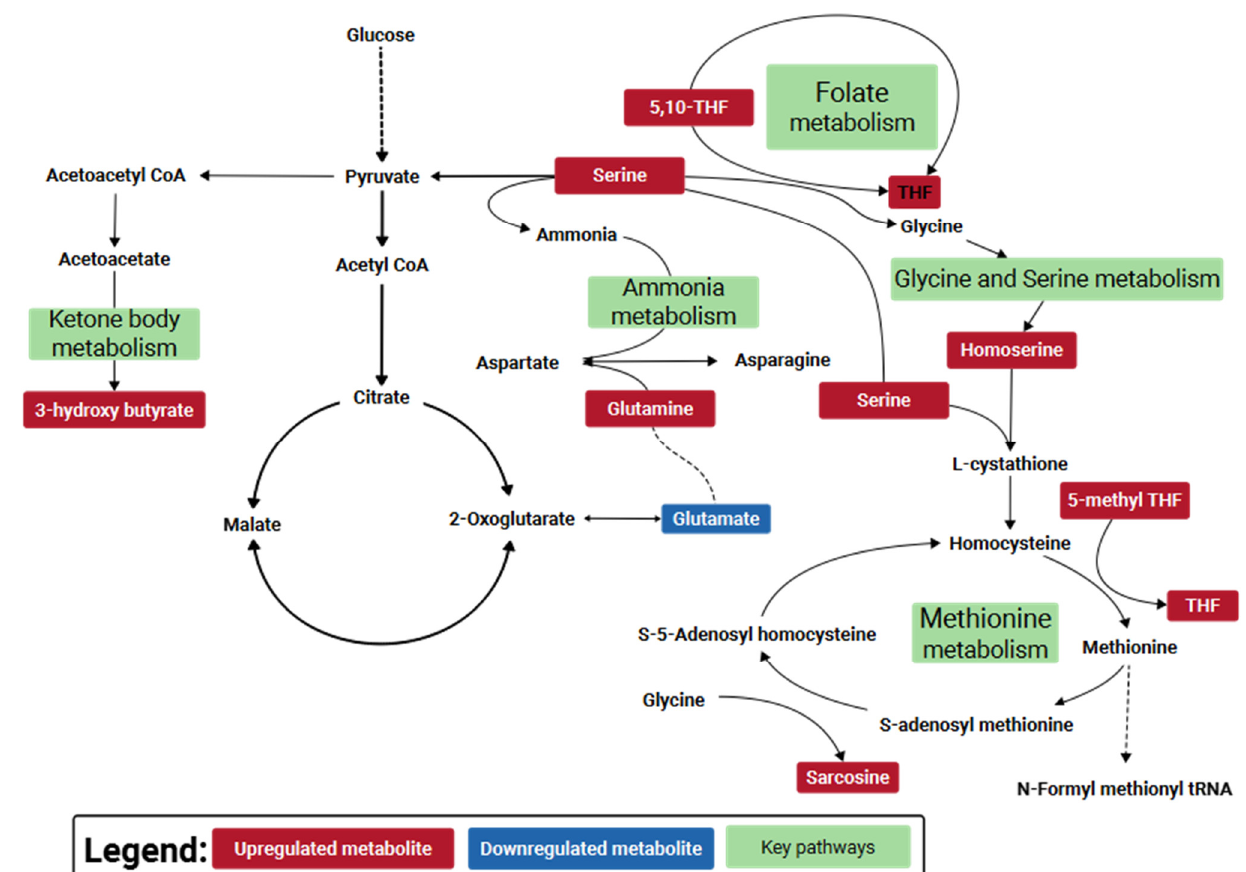
Figure 10. Curated metabolic pathway of key metabolism changes in a SARS-CoV-2 ferret model infected with the SA01 isolate during virus shedding. Note, red-colored metabolites are significant features that are upregulated during viral shedding when infected with SA01 isolate. Key metabolic pathways identified from the pathway enrichment and impact analysis are annotated green. The data for individual metabolites is presented in the Supplementary Figure S4.